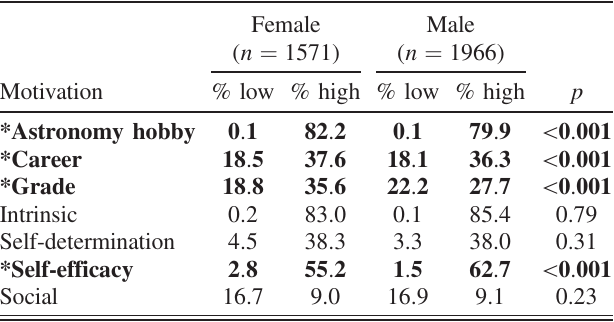
TABLE IV. Comparison of percentages of learners in low and high tiers of each motivational category for both genders. Statistically significant results at the p ¼ 0 . 05 level using the Kolmogorov-Smirnov two sample test are denoted with asterisks and in bold